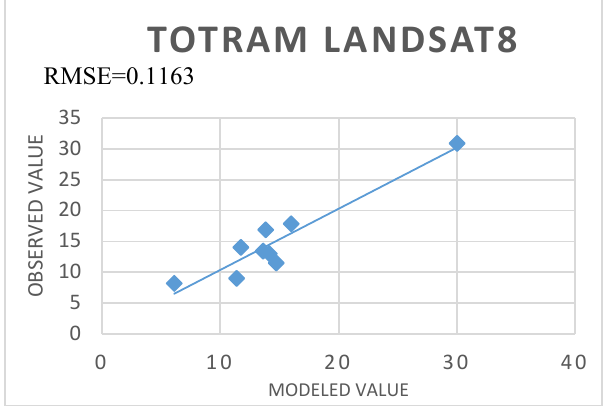
Figure 5: TOTRAM soil moisture estimation compared with insitu